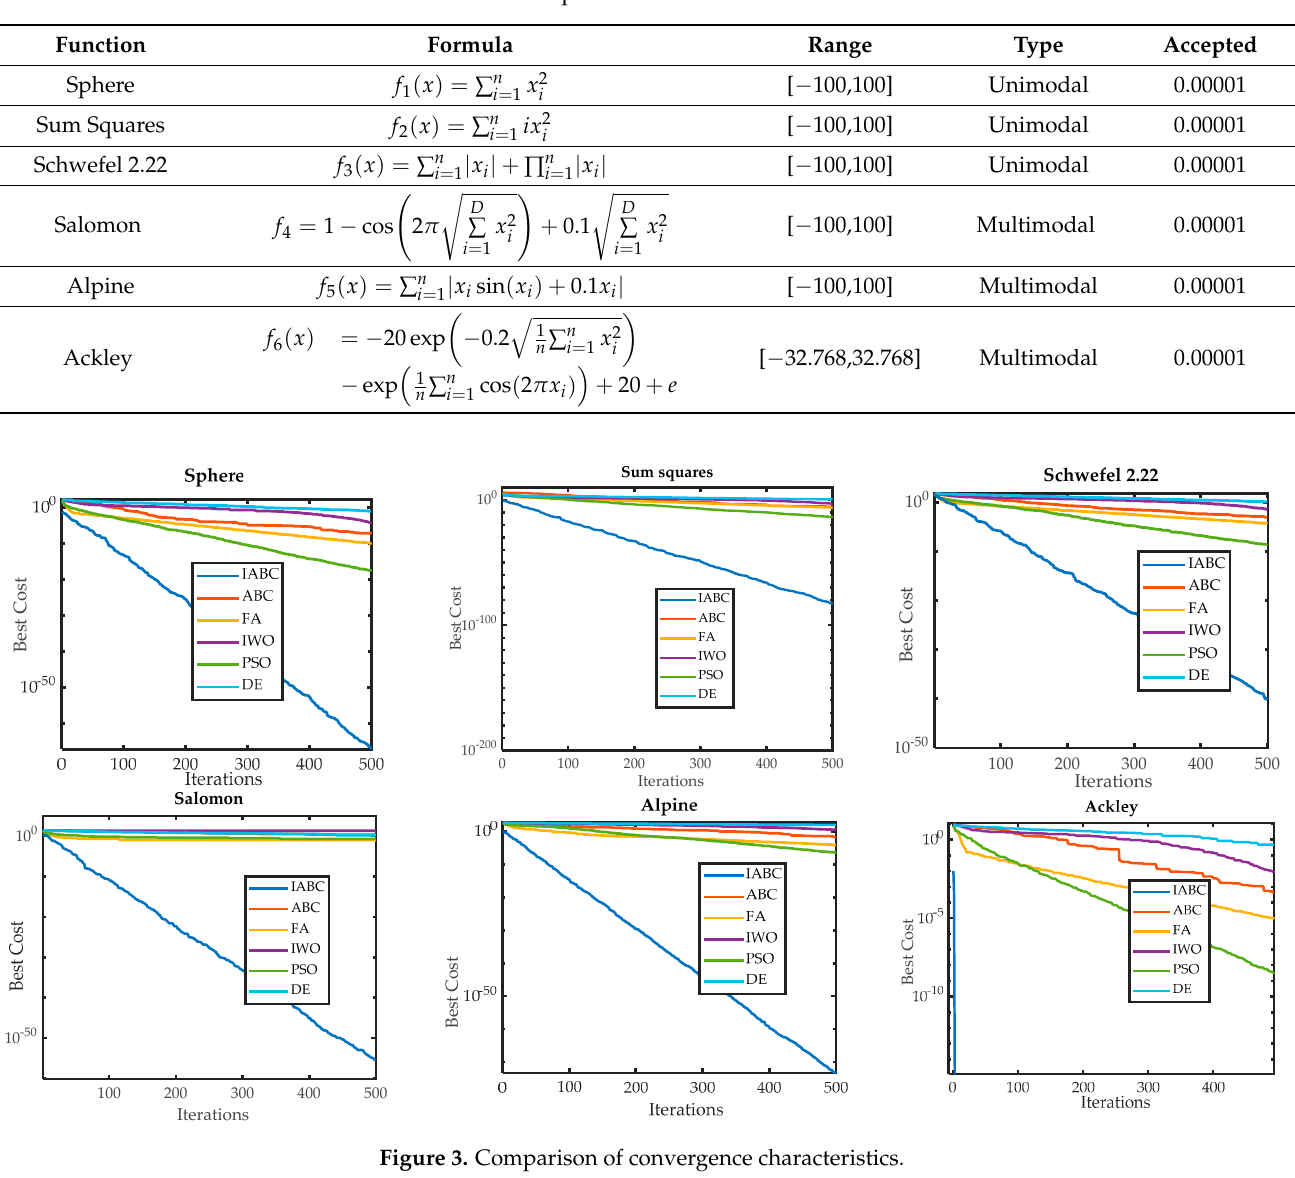
Table 1. Proprieties of the test functions.